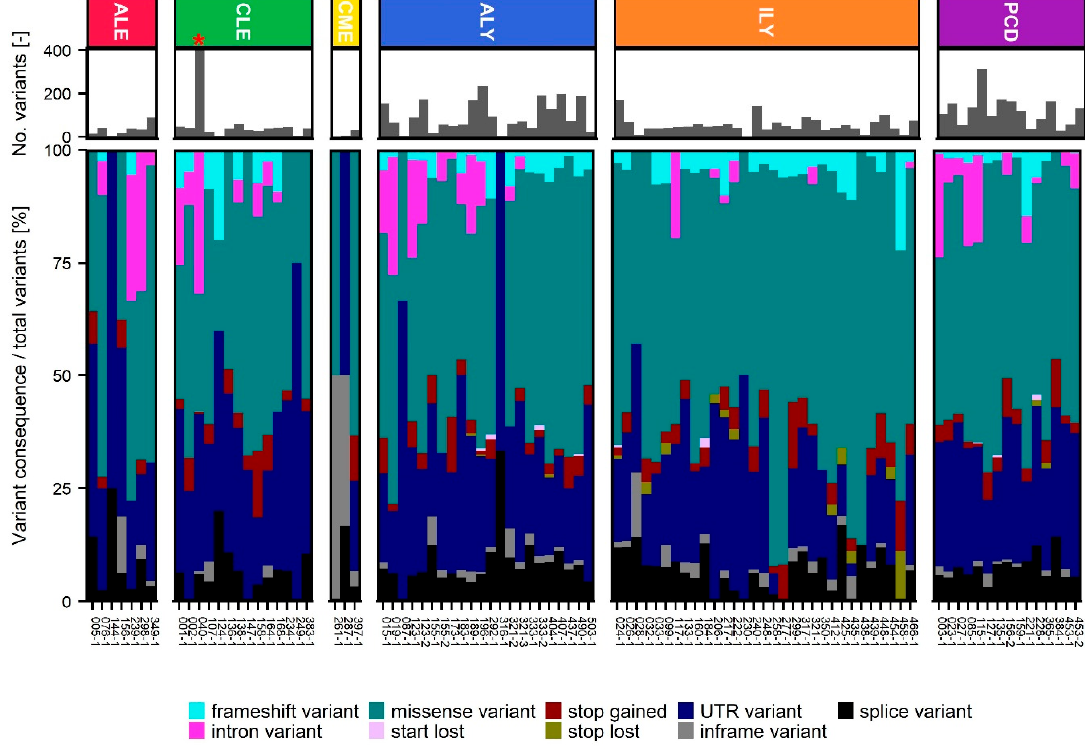
Figure 3. Small nucleotide variant (SNV) detection and filtering. Retained variants per patient grouped by type and divided into the six disease groups; ALE: Acute leukemia, CLE: Chronic leukemia, CME: Chronic Myeloid Neoplasms, ALY: Aggressive Lymphomas, ILY: Indolent Lymphomas, and PCD: Plasma Cell Diseases. * Sample contained 5061 variants and was not subjected to variant interpretation in Qiagen Clinical Insight Interpret.